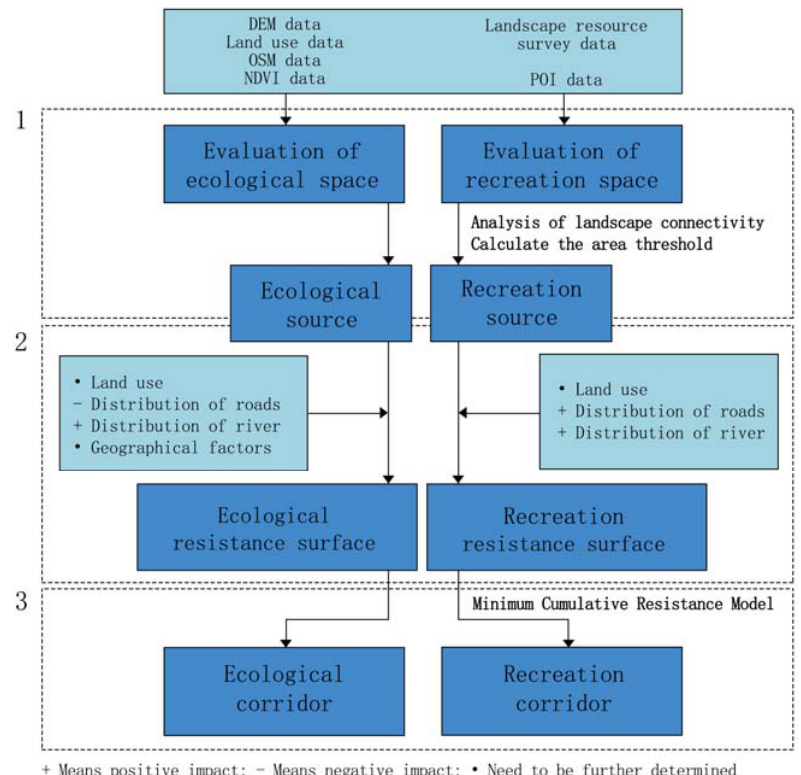
Figure 1. Research framework.